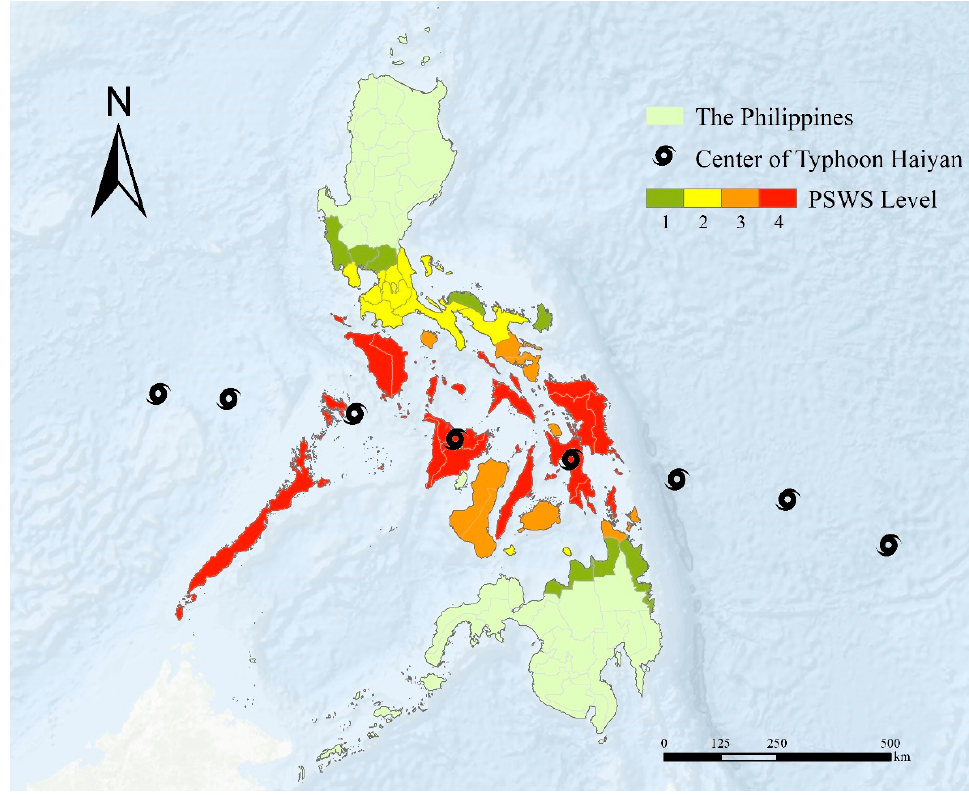
Figure 1. The path and Public Storm Warning Signal (PSWS) of Typhoon Haiyan in the Philippines. The larger the PSWS value, the higher the warning level.